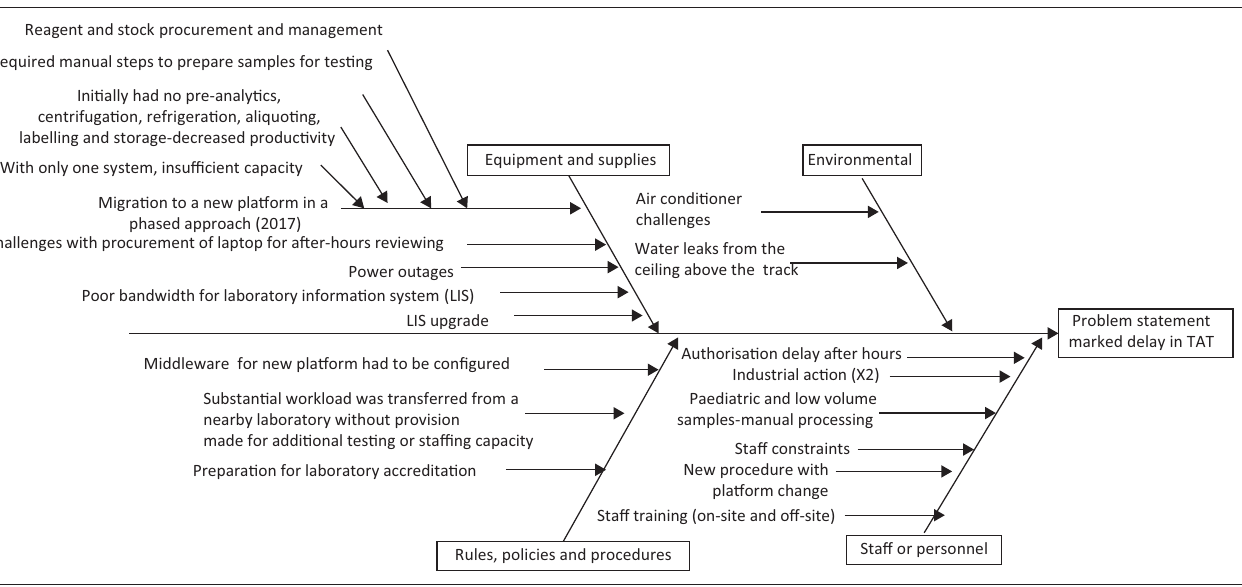
Reagent and stock procurement and management